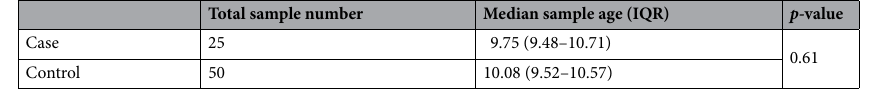
Table 5. Sample age (years). p -value in this table was calculated using the Mann–Whitney U test.